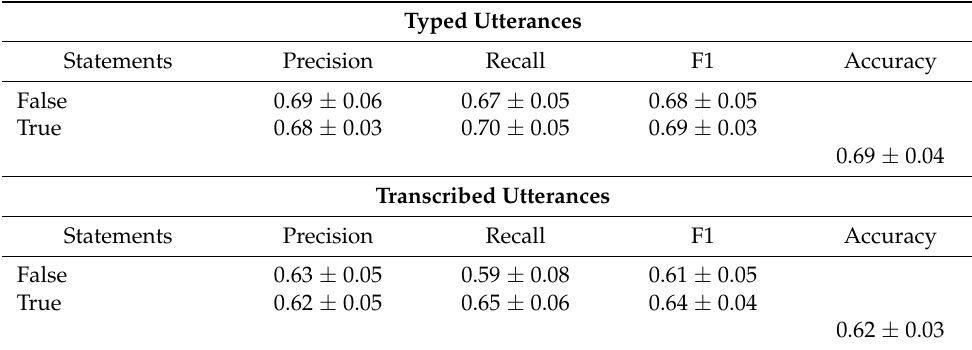
Table 4. USE+SVM results ( ± cross-validation standard deviations).